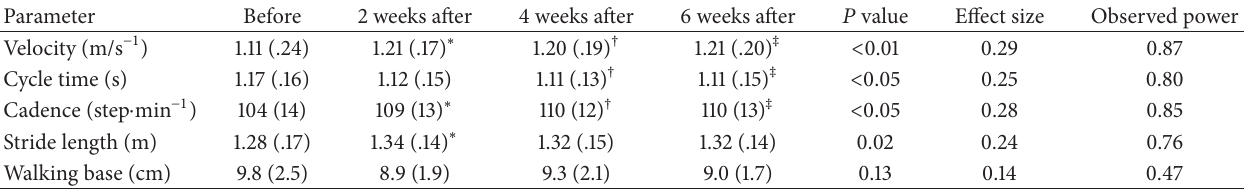
Table 2: Global and affected limb gait parameters before and after injection: Means (SD).